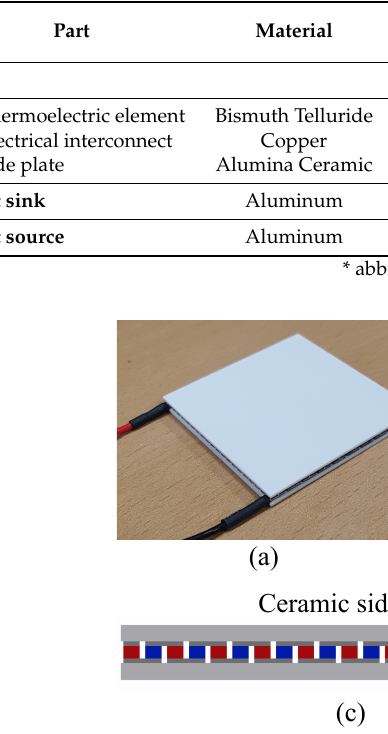
Table 2. Material properties for each component [35,39].